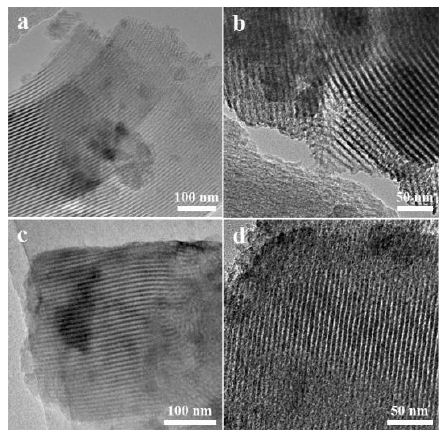
Figure 4. TEM images of ( a , b ) 0.2%Pd/SBA-15; ( c , d ) 0.2%Pd-1.2%Ni/SBA-15.